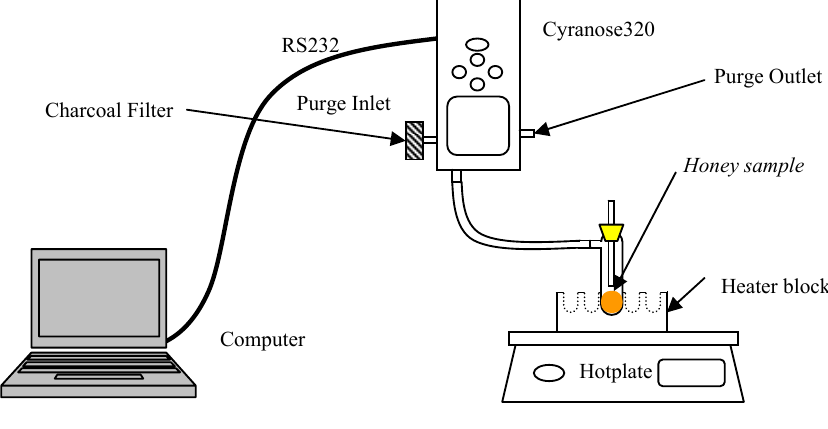
Figure 1. E-nose setup for headspace evaluation of honey, sugar concentration and adulteration sample.